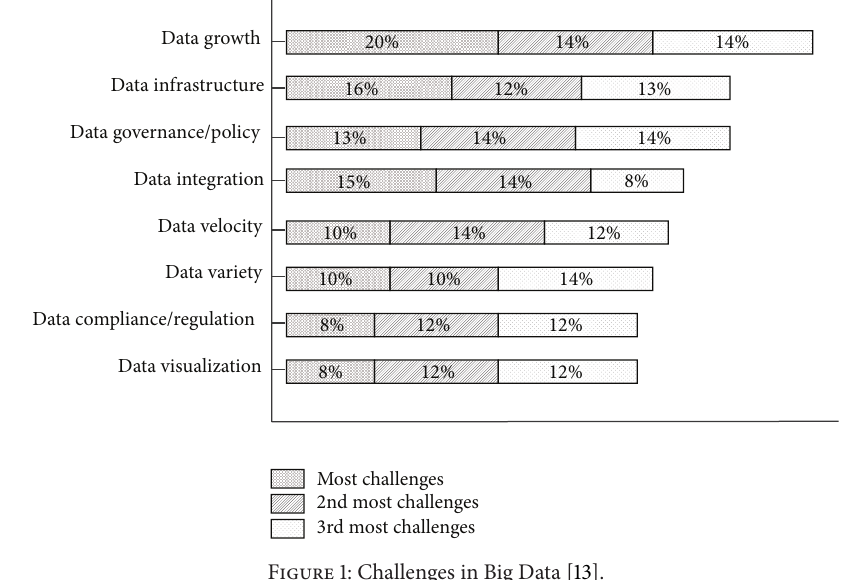
Figure 1: Challenges in Big Data [13]. Table 1: Rapid growth of unstructured